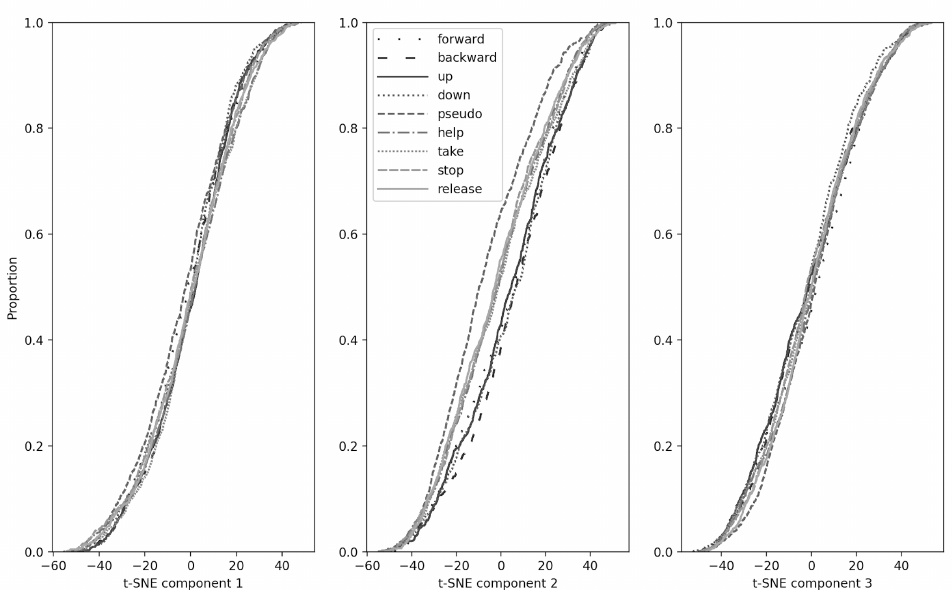
Figure 10. The resulting distributions of the three components of t-SNE were grouped relative to the words silently “pronounced” by the subjects and analyzed for belonging to the same general population by the Kolmogorov–Smirnov